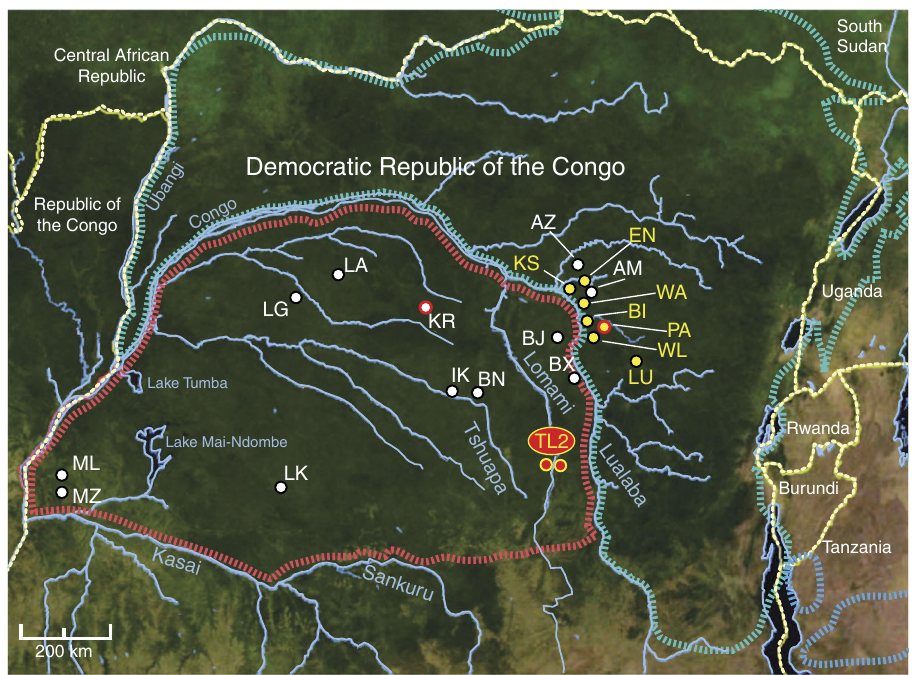
Fig. 1 Plasmodium infections of wild-living bonobos. Ape study sites are shown in relation to the ranges of the bonobo ( P. paniscus , dashed red) and the eastern chimpanzee ( P. t. schweinfurthii , dashed blue), with white dots indicating sites where no Plasmodium infection was found (see Table 1 and Supplementary Table 3 for a list of all fi eld sites and their code designation). The Tshuapa – Lomami – Lualaba (TL2) site where bonobos are endemically infected with multiple Plasmodium species, including a newly discovered Laverania species (B1), is shown in red with two dots indicating sampling on both sides of the Lomami River. Eastern chimpanzee fi eld sites with endemic P. reichenowi, P. gaboni and/or P. billcollinsi infections are shown in yellow. A red circle highlights one bonobo (KR) and one chimpanzee (PA) fi eld site where B1 parasite sequences were detected in a single faecal sample. Forested areas are shown in dark green, while arid or semiarid areas are depicted in brown. Major lakes and rivers are shown in blue. Dashed yellow lines indicate national boundaries. The scale bar indicates 200